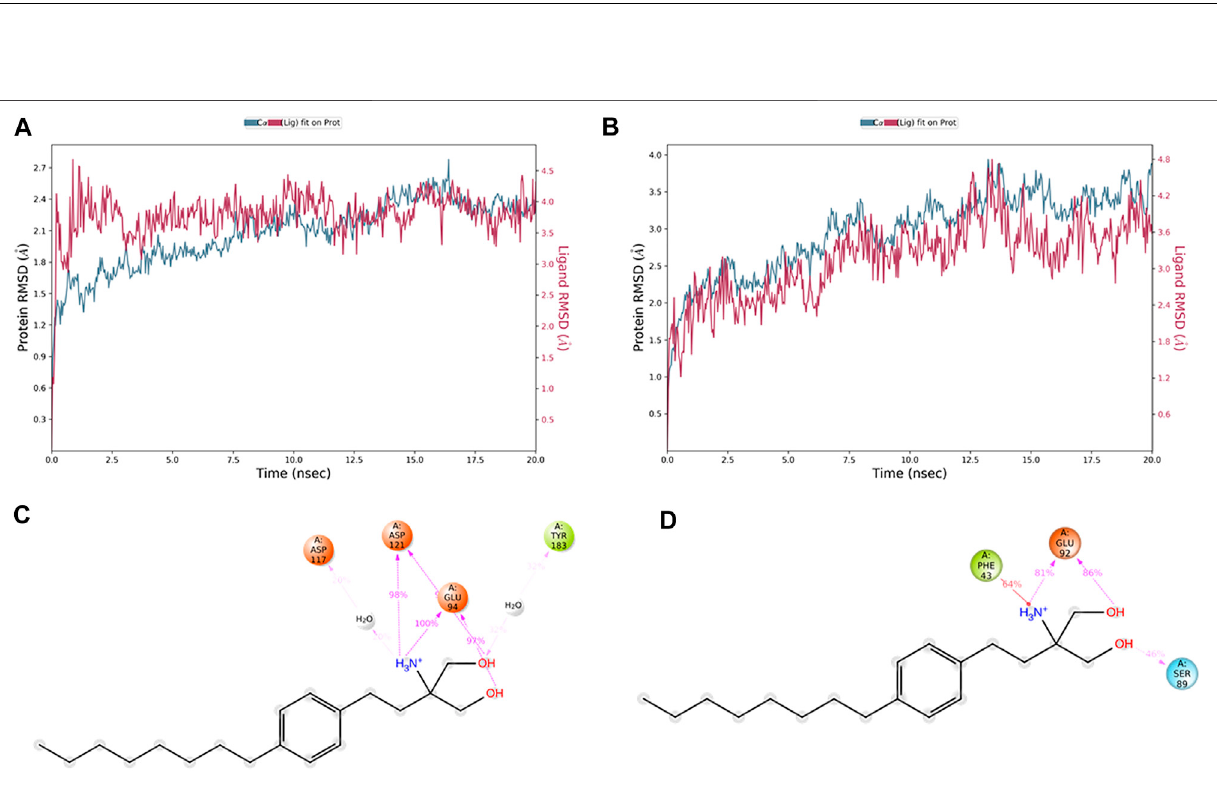
FIGURE 6 | Fingolimod stably bound to hMC1R and hMC5R during 20 ns MD simulation. (A) root mean square deviation (RMSD) of hMC1R (blue plot) and fi ngolimod (red blot) during 20 ns of MD simulation, of the complex embedded in a POPC membrane. (B) RMSD of hMC5R (blue plot) and fi ngolimod (red blot) during 20 ns of MD simulation, of the complex embedded in a POPC membrane. (C) Fingolimod interactions with hMC1R, and frequency (%) during 20 ns MD simulation. (D) Fingolimod interactions with hMC5R, and frequency (%) during 20 ns MD